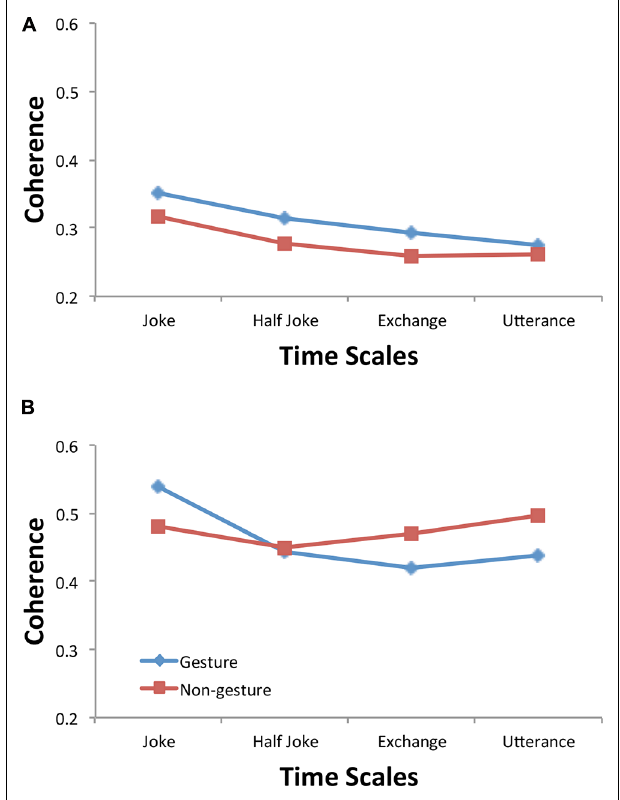
FIGURE 5 |Wavelet coherence at the four joke time scales by motion conditions for the virtual (A) and experimental (B) participant pairs.